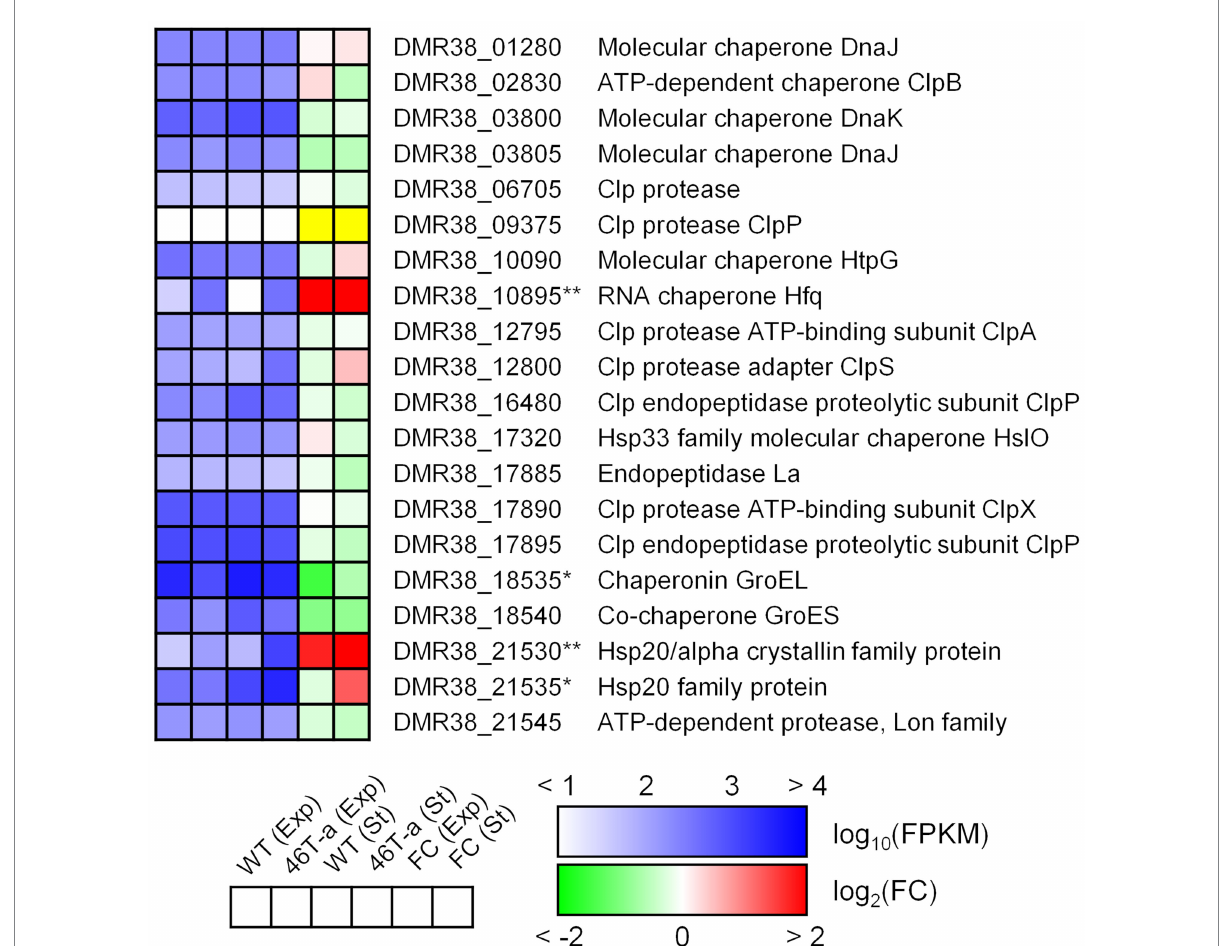
FIGURE 7 Transcription profiles of selected genes involved in general stress response. The colorimetric scale is the same as in Figure 5. The yellow color in the fold change box indicates that the fold change value might not be valid because both FPKM values were too low (<10). Single and double asterisks next to the locus tag indicate differential expression with statistical significance (|log 2 (folds)| > 1 and FDR < 0.001) in one and two phases,